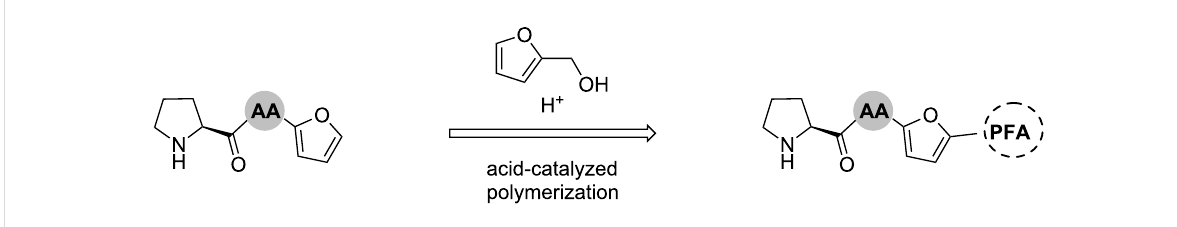
Scheme 1: Schematic synthesis of polyfurfulyl alcohol (PFA) incorporating a prolyl peptide catalyst. AA: Amino